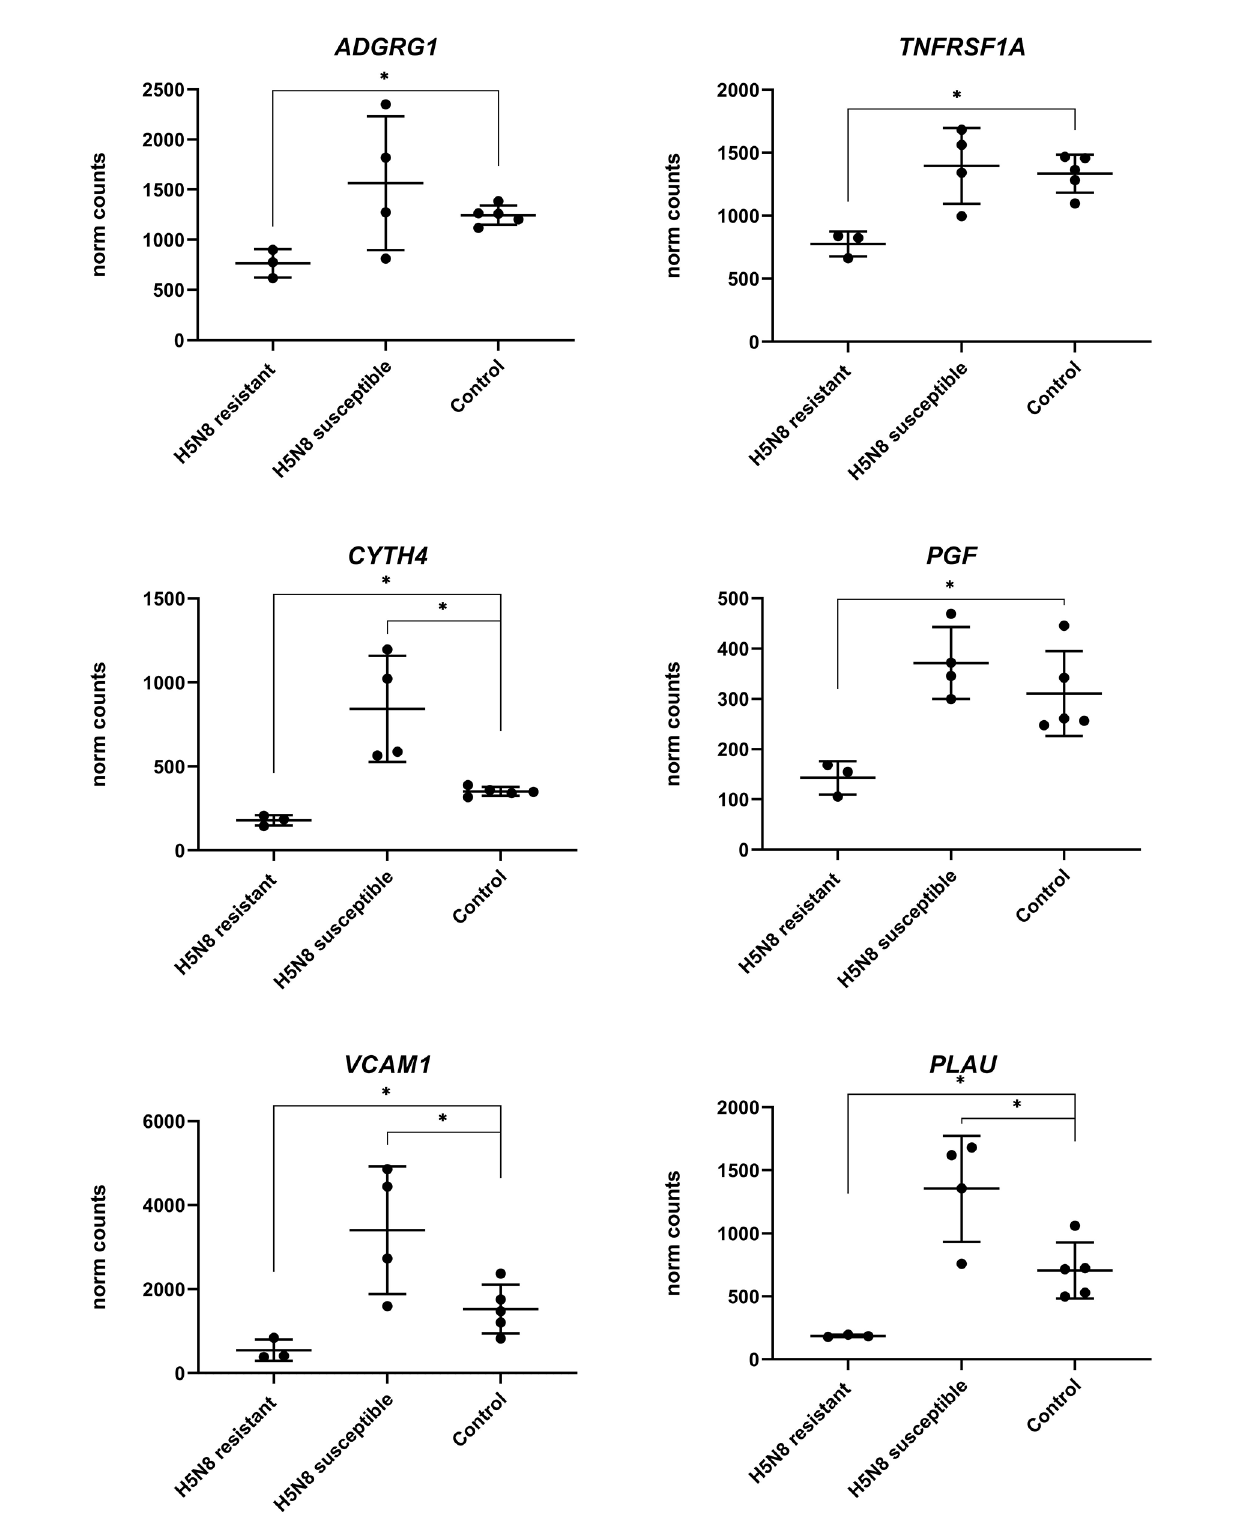
FIGURE 7 | Expression levels of the six genes with opposite regulation between resistant and susceptible chickens inoculated with H5N8 virus from lungs collected at 3 dpi. For each group the mean and standard deviation are shown. ( ∗ ) BH adjusted P ≤ 0.05 from Wald test p-value with